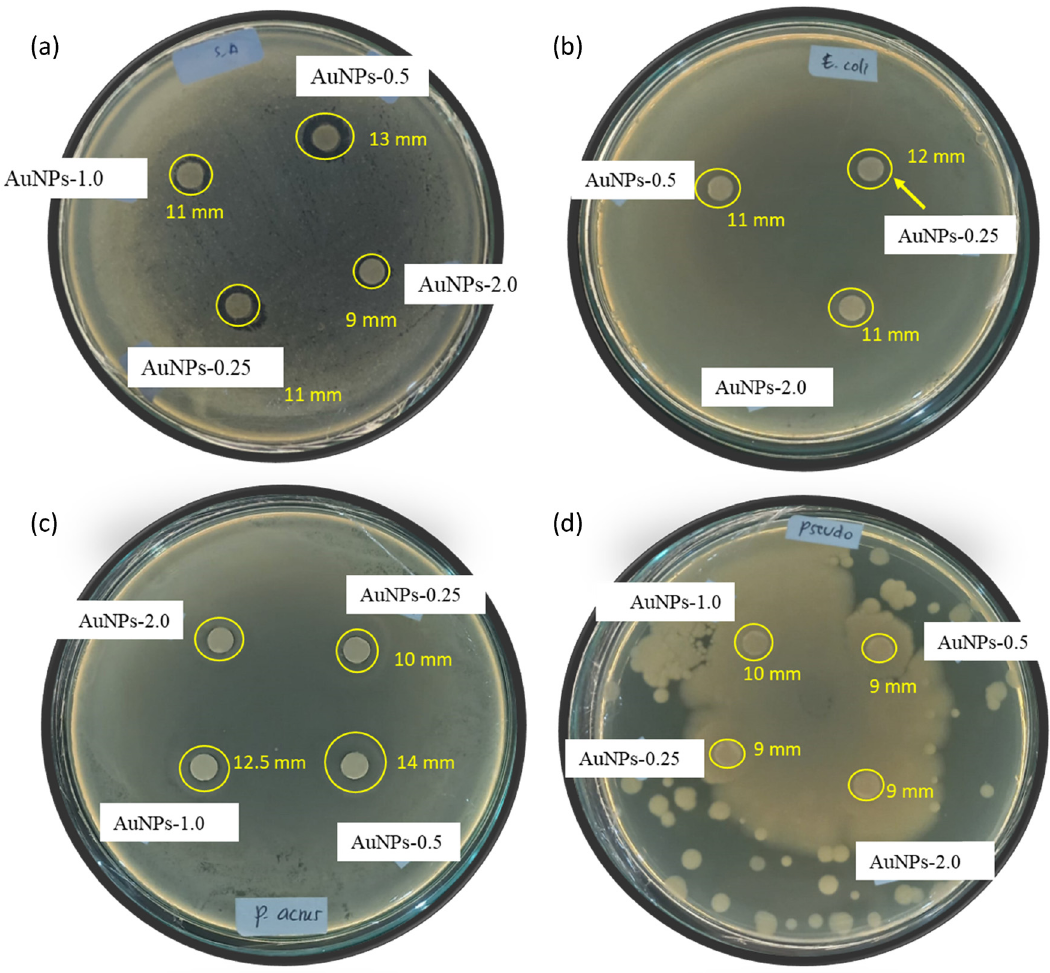
Figure 6: Some images from antibacterial activity test of AuNPs against ( a ) S. aureus , ( b ) E. coli , ( c ) P. acnes , ( d ) P. aeruginosa